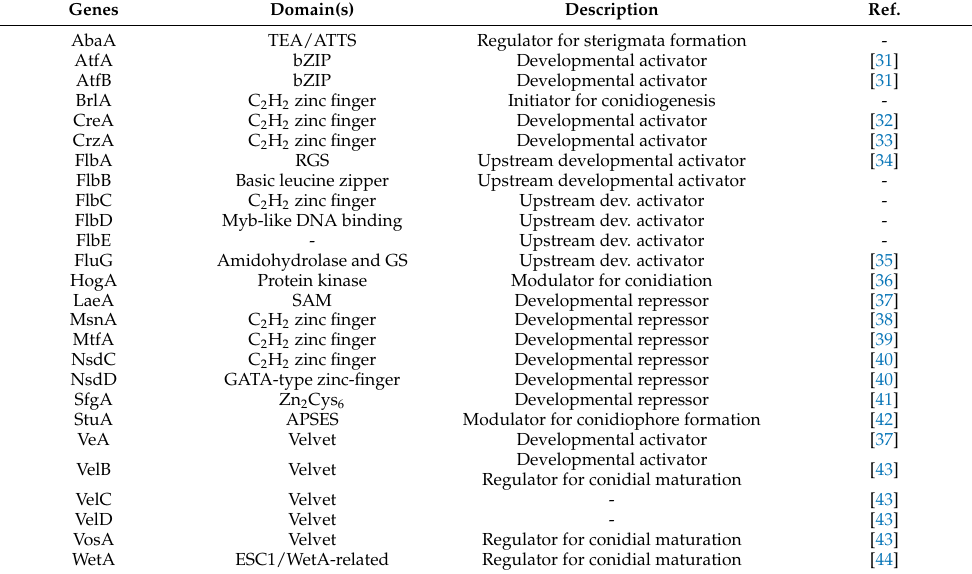
Table 1. The function of the major developmental regulators in studied A. flavus